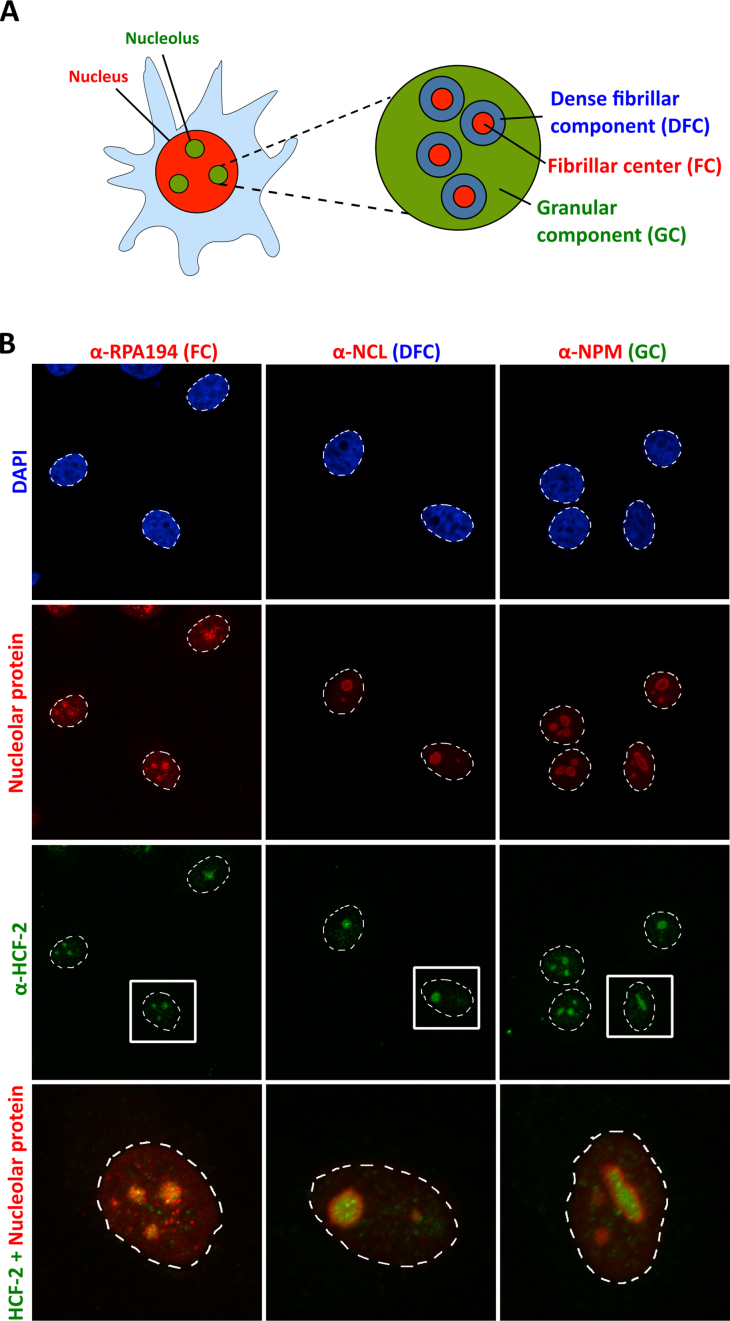
HCF-2 is localized in the fibrillar center of nucleolar compartment. (A) Diagram of mammalian nucleolus with fibrillar centers (FC, red) surrounded by dense fibrillar component (DFC, blue) and further encircled by the granular component (GC, green). (B) Co-immunostaining of HeLa cells with α-HCF-2 antibody (green) and (left to right) antibodies for markers for the different subnucleolar regions (red): RPA194 (FC), NCL (DFC) and NPM (GC). Upper panels, nuclear staining with DAPI (blue). Bottom panels, enlargement of one cell with merge of HCF-2 and nucleolar maker signals is shown. Dashed line denotes the nuclear area.